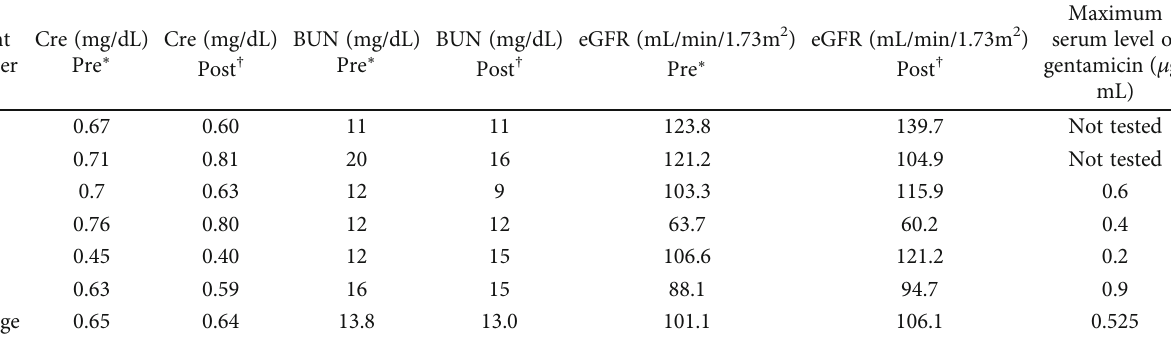
Table 3: Summary of renal function and maximum serum level of